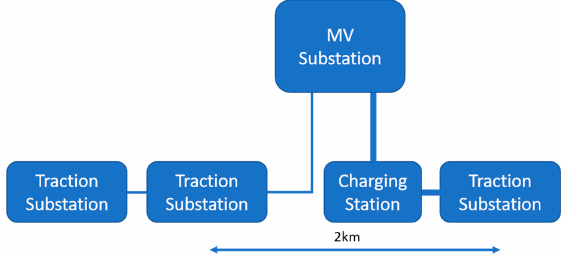
Figure 6. Illustration of the hybrid infrastructure. Figure6